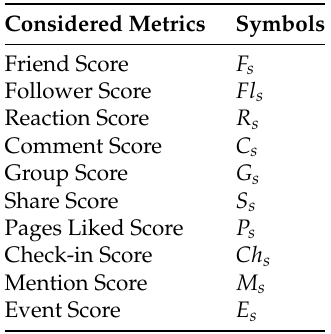
Table 6. Symbols and their